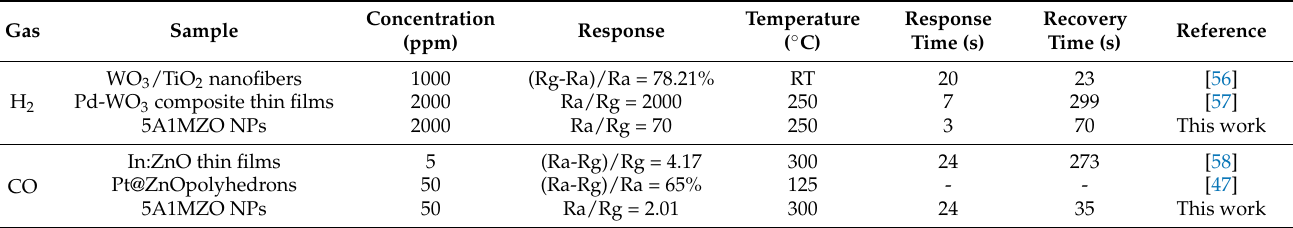
Table 2. Comparison of the results of current work with those recently reported on resistance type sensors for H 2 and CO. Gas